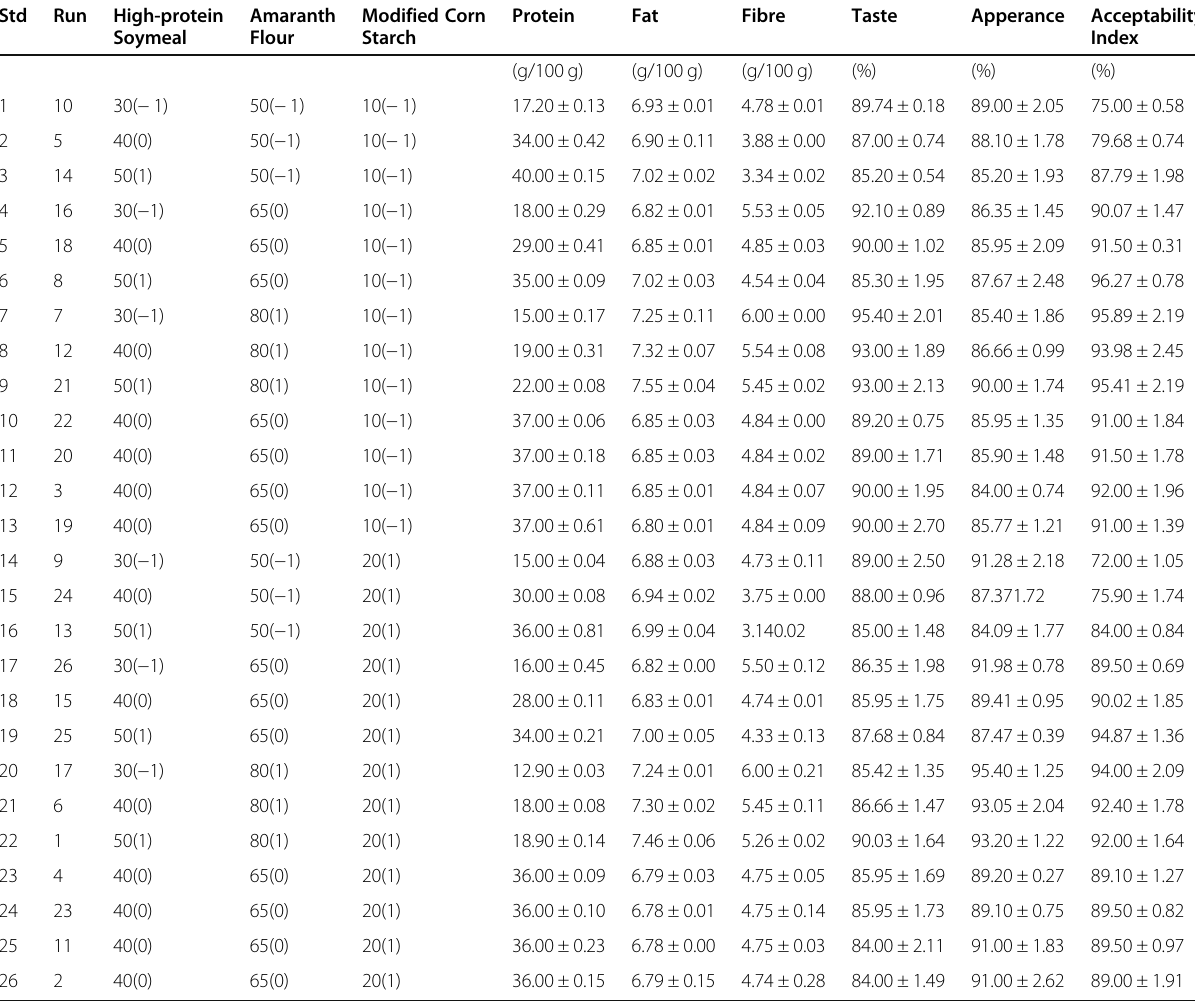
Table 1 Experimental design and quality attributes of consumer ready flakes from amaranth, high-protein soymeal and modified corn starch Std Run High-protein Amaranth Soymeal